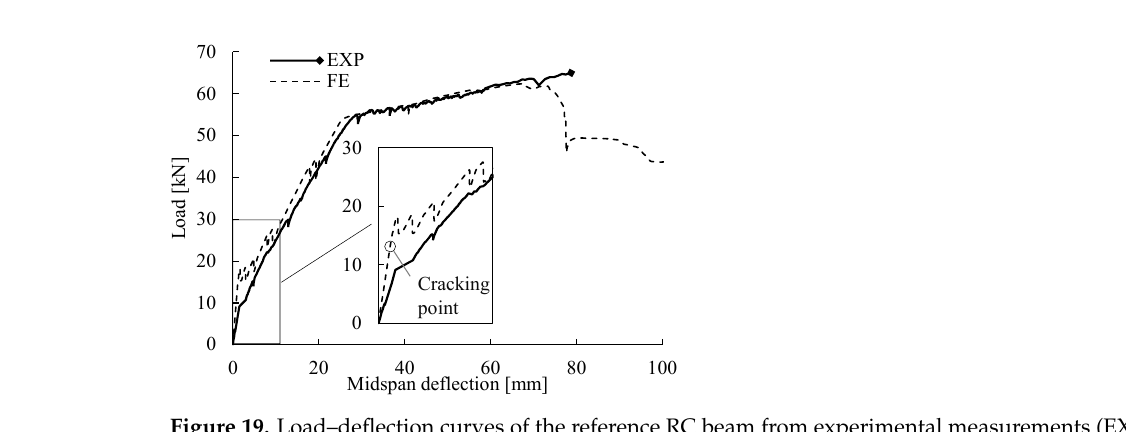
Figure 19. Load–deflection curves of the reference RC beam from experimental measurements (EXP) and FE analysis (FE).